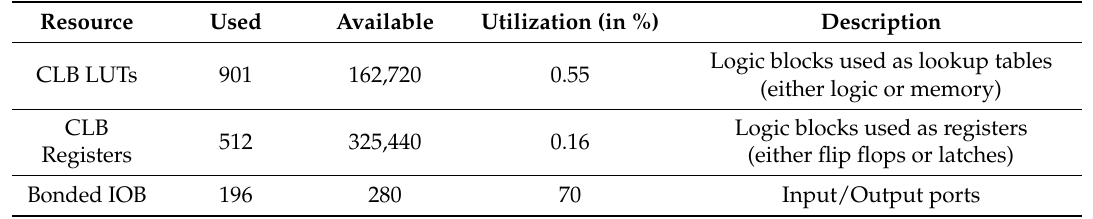
Table 2. Utilization results